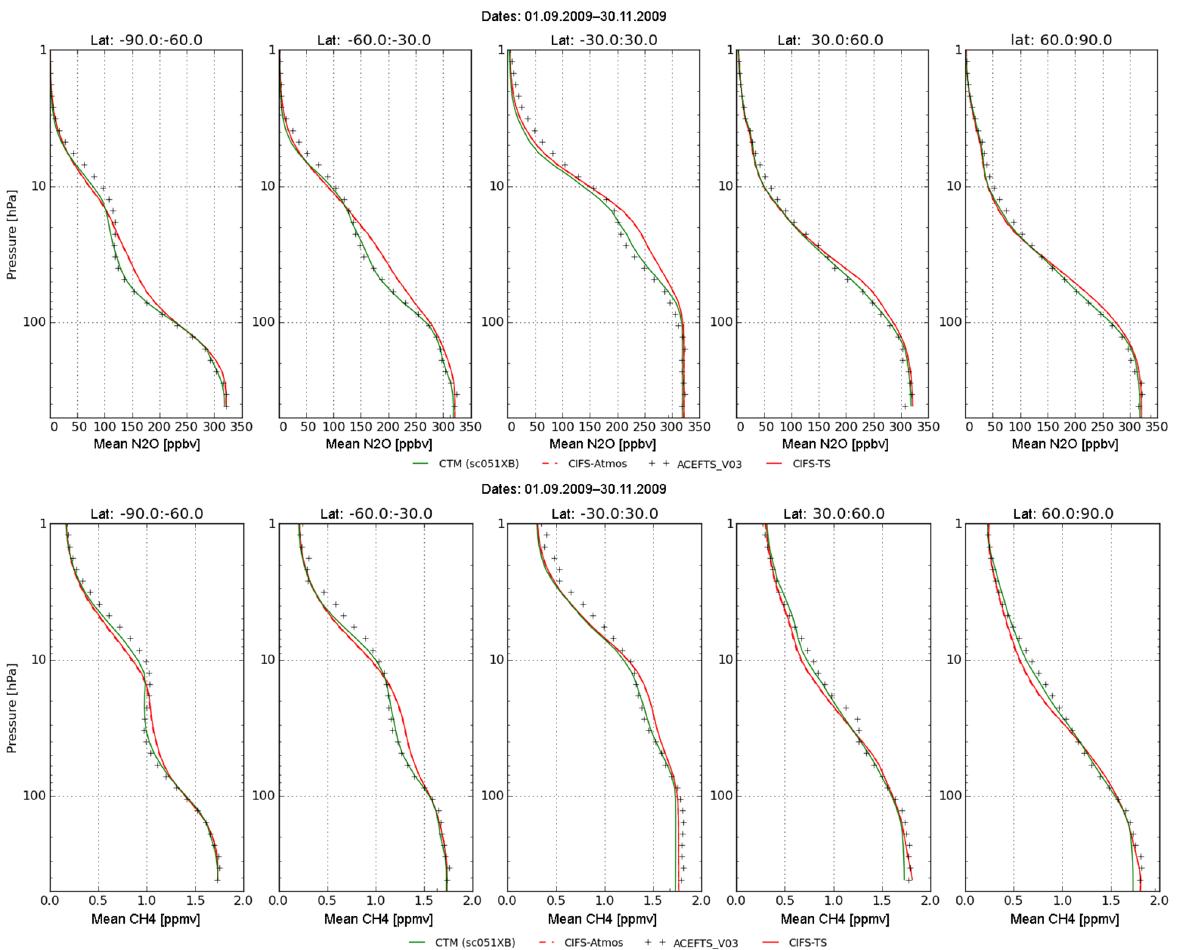
Figure 9. Zonal mean profiles of stratospheric N 2 O (top) and CH 4 (bottom) for September–October–November 2009 using ACE-FTS observations (black symbols) and co-located output of BASCOE-CTM (green lines), C-IFS-TS (red solid lines) and C-IFS-Atmos (red dashed lines). The zonal means are shown separately in five columns corresponding to the latitude bands 90–60 ◦ S, 60–30 ◦ S, 30 ◦ S–30 ◦ N, 30–60 ◦ N and 60–90 ◦ N,